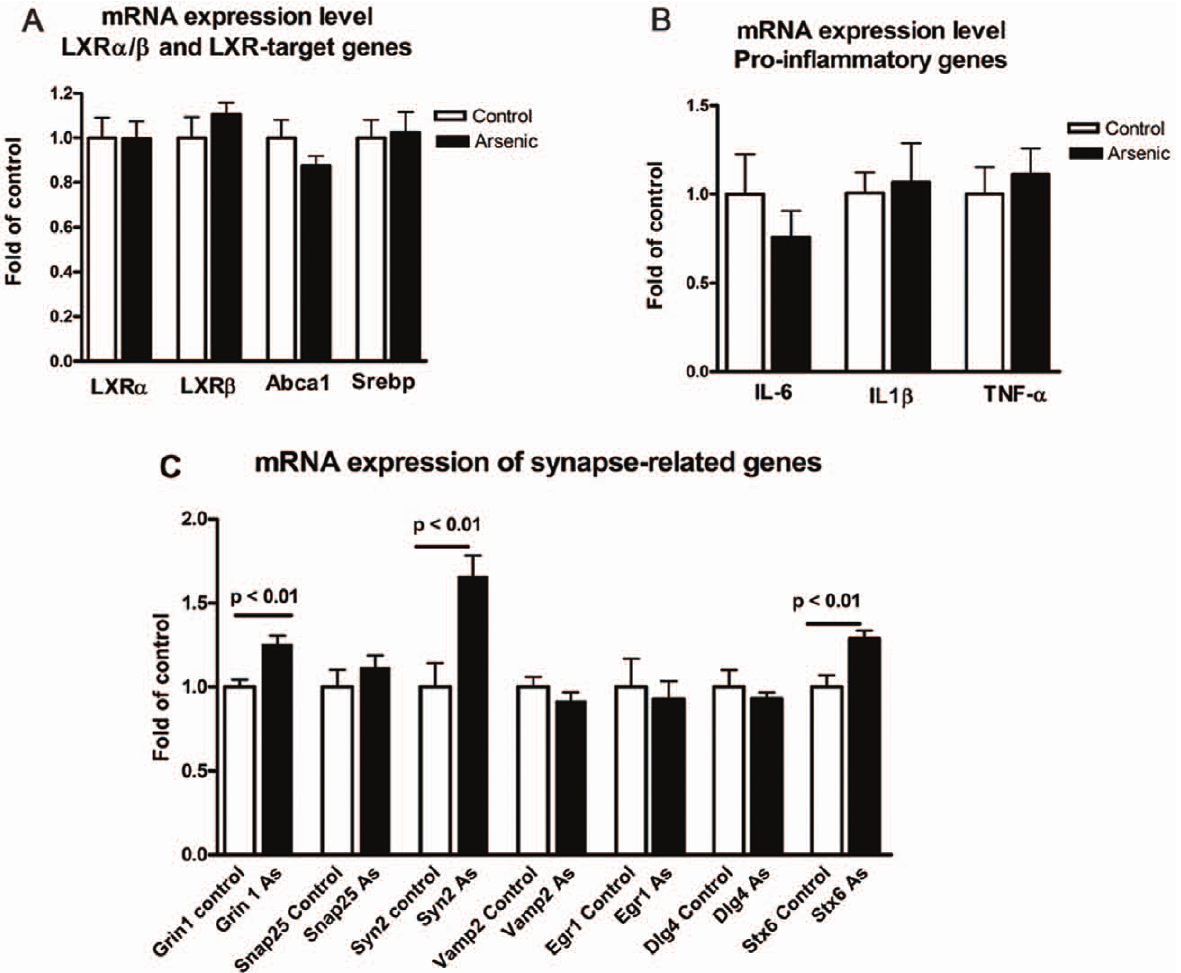
Figure 6. Effect of arsenic on gene expression level. Six months old C57BL6/J mice were exposed to 100 ppb arsenic supplied in the drinking water for 3 weeks and control mice received plain water. RNA was isolated from the cortices and mRNA expression level determined by RT-QPCR. A . Expression levels of LXR a / b and principal LXR-target genes are not changed by arsenic exposure. B . Exposure to arsenic does not change the expression level of pro-inflammatory genes. C . mRNA expression of selected synapse-related proteins in response to arsenic exposure. Abbreviations: Abca1 ATP-binding cassette, sub-family A, member 1 (Abca1), Sterol regulatory element binding transcription factor 1 (Srebp), Glutamate receptor, ionotropic, N-methyl D-aspartate 1 (Grin1), Discs, large homolog 4 (Dlg4), Phosphatidylinositol binding clathrin assembly protein (Picalm), Synatosomal-associated protein, 25 kDa (Snap25), synapsin II (Syn2), Vesicle- associated membrane protein 2 (Vamp2), Early growth response 1 (Egr1), Syntaxin 6 (Stx6), Nuclear receptor subfamily 1, group H, member 3 (LXR a ), Nuclear receptor sub- family 1, group H, member 2 (LXR b ), Interleukin 6 (Il6), Interleukin 1 beta (Il1 b ), Tumor necrosis factor (Tnf), Cytochrome c oxidase subunit II (Cox-2) and Ribosomal protein, large, P0 (M36b4).